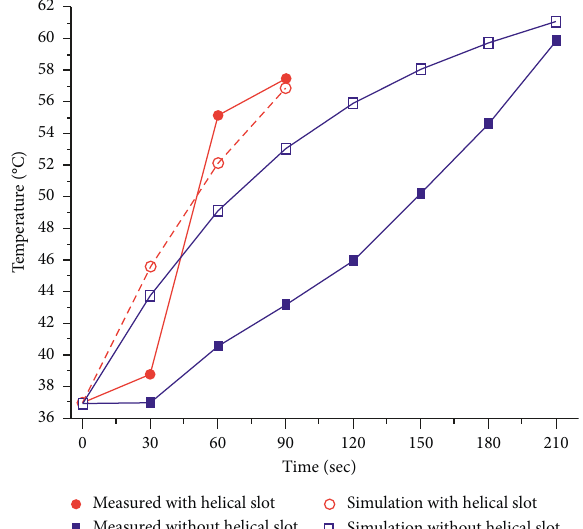
Figure 8: Comparison of temperature distributions over time in the case of antennas with helical slot and without